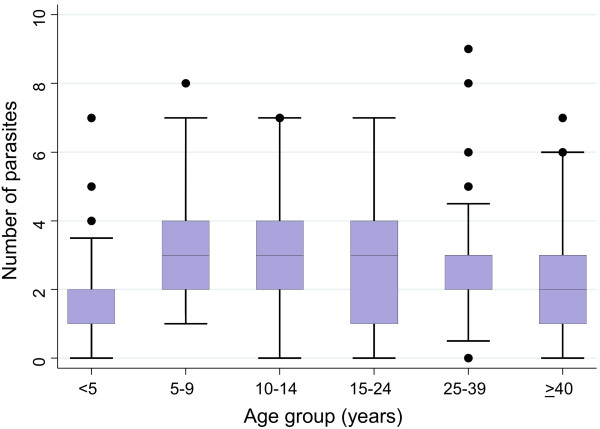
Number of concurrent parasitic infections, stratified by age group. Rate of polyparasitism among 912 study participants with complete parasitological data. Box plot: boxes illustrate the 25th and 75th percentiles (ptile), while the whiskers indicate the adjacent lower and upper values (most extreme values which are within 25th ptile - 1.5*(75th-25th ptile) and 75th ptile + 1.5*(75th-25th ptile), respectively). The median is shown by the line within the boxes, outliers are indicated with dots.